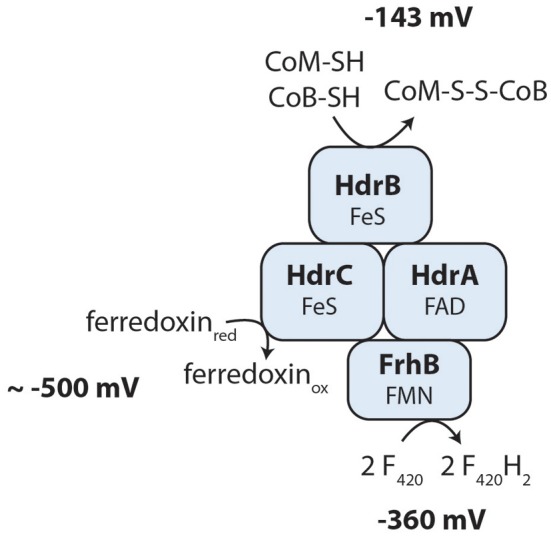
Hypothesis of a novel cytoplasmic electron confurcating heterodisulfide reductase complex for ferredoxin and CoM-S-S-CoB recycling. The exergonic reduction of F420 (E0′ = −360 mV) with reduced ferredoxin (E0′ ≈−500 mV) may be coupled to the endergonic electron transfer from the thiol cofactors CoM-SH and CoB-SH (E0′ = −143 mV) to F420. This hypothesis is based on the metabolic reconstruction using genome and transcriptome sequencing and is not yet supported by biochemical experiments. FAD, flavin adenine dinucleotide; FMN, flavin mononucleotide; FeS, iron-sulfur cluster; FrhB, F420-reducing hydrogenase subunit B; HdrABC, heterodisulfide reductase subunits A, B, C.